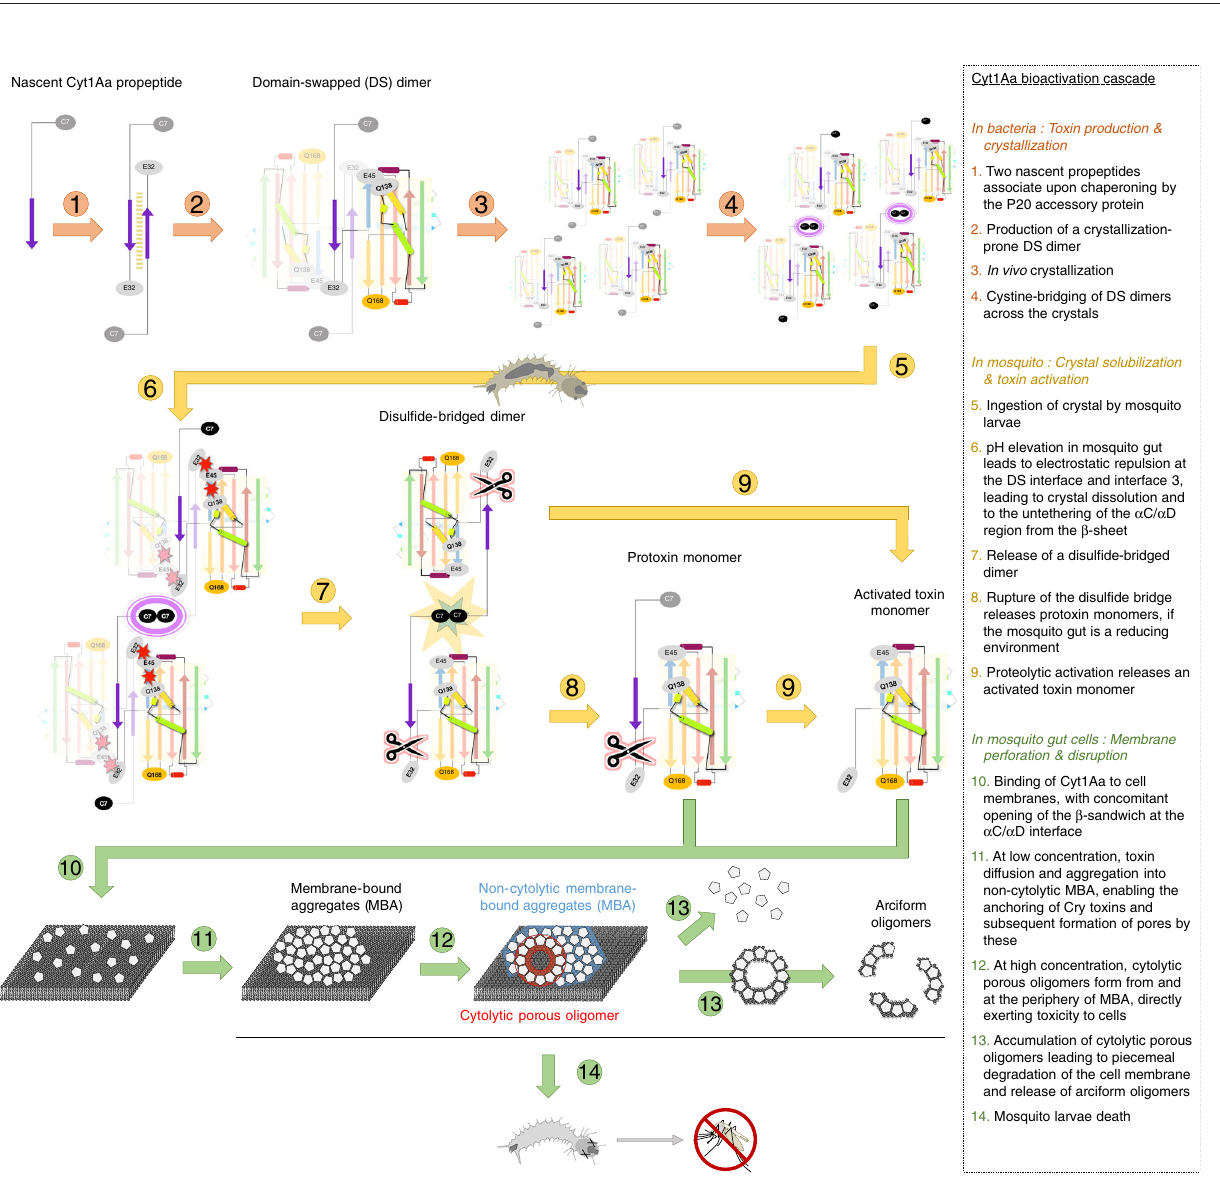
Fig. 6 Proposed model for Cyt1Aa bioactivation cascade. The bioactivation cascade of Cyt1Aa starts with dimerization through a domain-swapped interface, which allows both self-inhibition and in vivo crystallization, and ends with oligomer formation in the membrane of mosquito gut cells. The Cyt1Aa structure is abstracted and colored sequence-wise, from cold (N-terminus) to hot (C-terminus) colors. The magenta square highlights the disul fi de bridge between domain-swapped (DS) dimers. Red starbursts indicate electrostatic repulsion, whereas the yellow-blue starburst indicates disul fi de bridge disruption. Conformational changes occur in the toxin upon pH elevation, resulting in an untethering of the α C/ α D hairpin from the β -sheet. We propose that upon contact with a cell membrane, the protein fully opens at the α C/ α D hydrophobic interface and that the two thereafter exposed hydrophobic surfaces appose onto the membrane bilayer, yielding the membrane-bound aggregate (MBA) conformer. Aggregation of MBA conformers eventually results in the formation of holes, at the periphery of MBA, resulting in the death of midgut